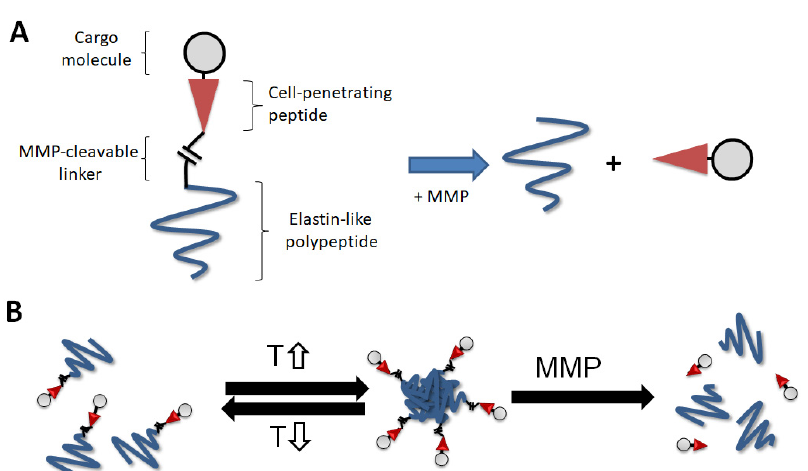
Figure 1. Elastin-like peptide (ELP) drug delivery system. ( A ) The proposed ELP system consists of an elastin-like polypeptide, matrix metalloproteinase (MMP)-cleavable linker, cell-penetrating peptide (CPP), and cargo molecules. The constructs are digested by the MMP, releasing the CPP cargo molecule. ( B ) The hypothetical model proposed in this system. The ELP constructs can form aggregates and release the CPP cargo molecule in hyperthermic tumors (T, temperature).